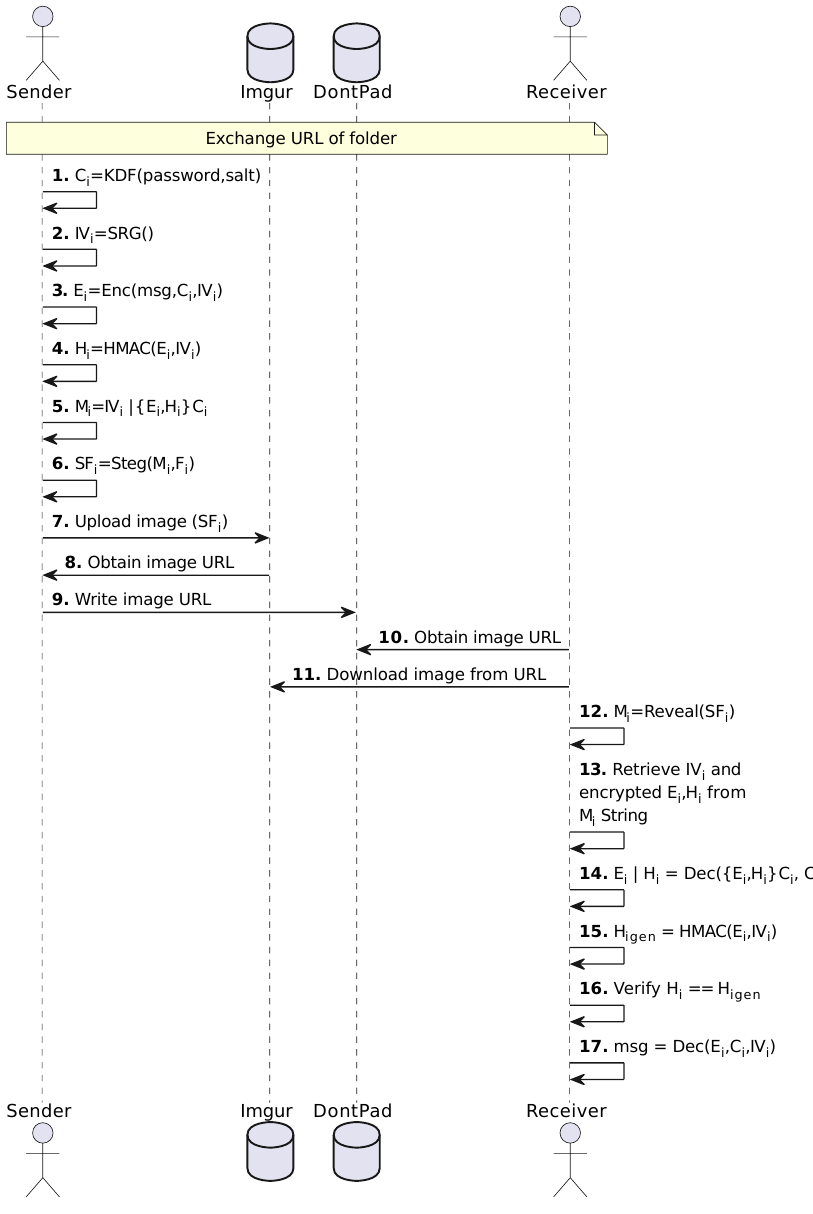
Figure 3. Sequence diagram of the proposed message